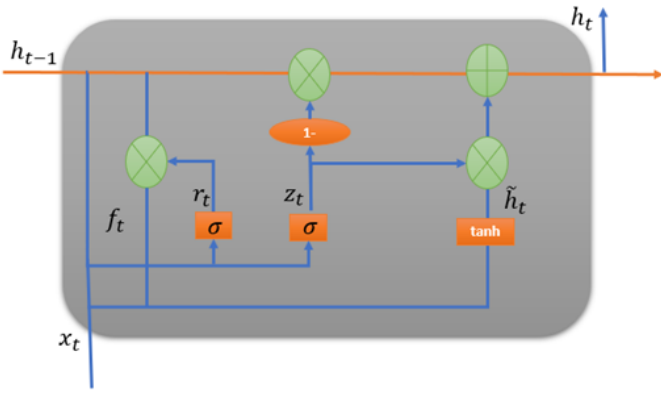
Figure 2. The cell structure of a gated recurrent